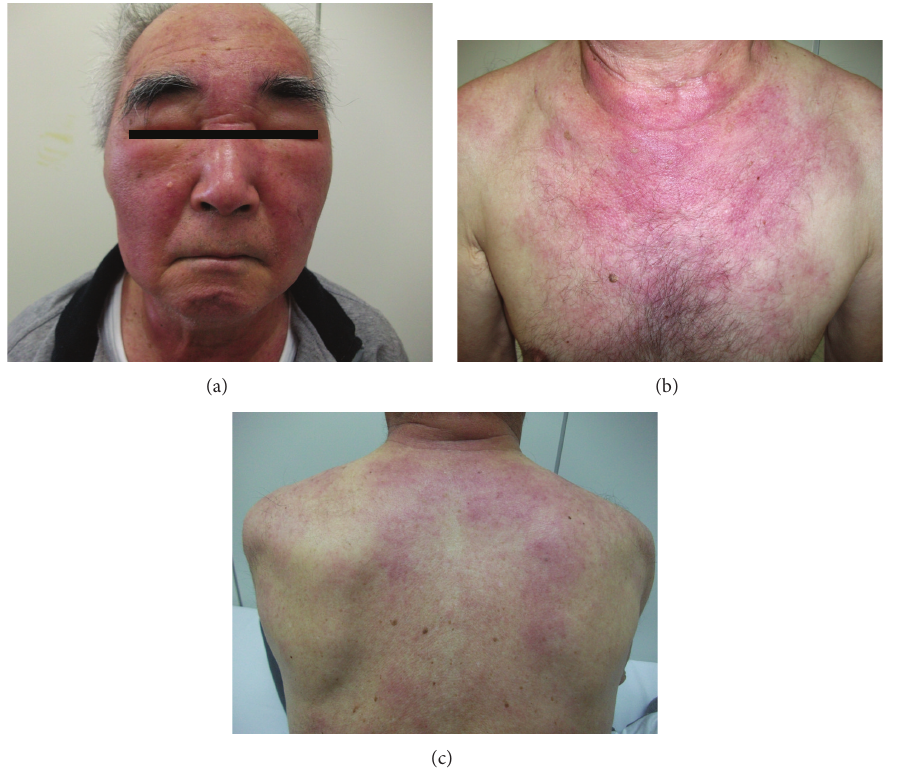
Figure 1: Facial edema/rash (a) and skin lesions at the neck/upper chest (b) as well as at the upper back (c).